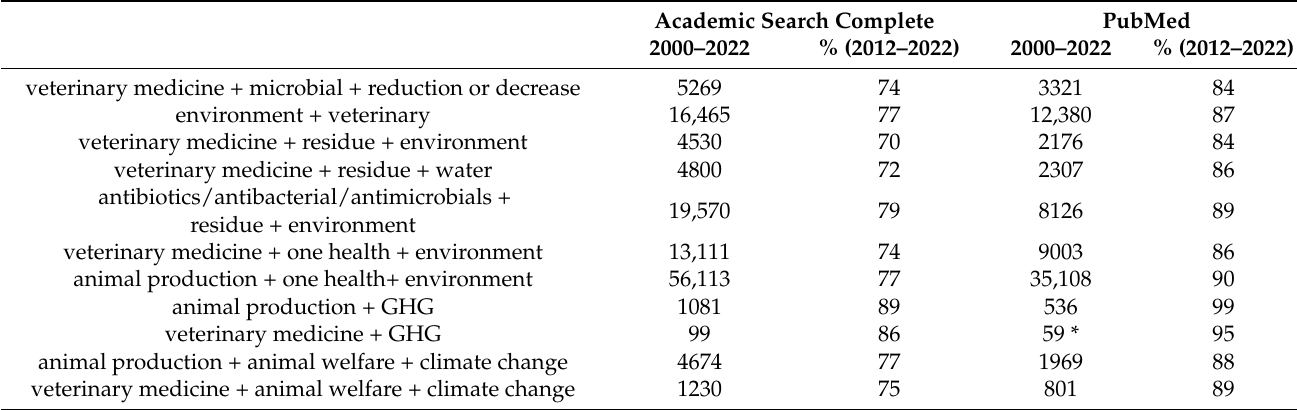
Table 3. Results from the mini-review conducted to quantify the number of scientific articles related to environmental issues and veterinarians published in 2000 to 2022 period and them percentage of them published during the last ten